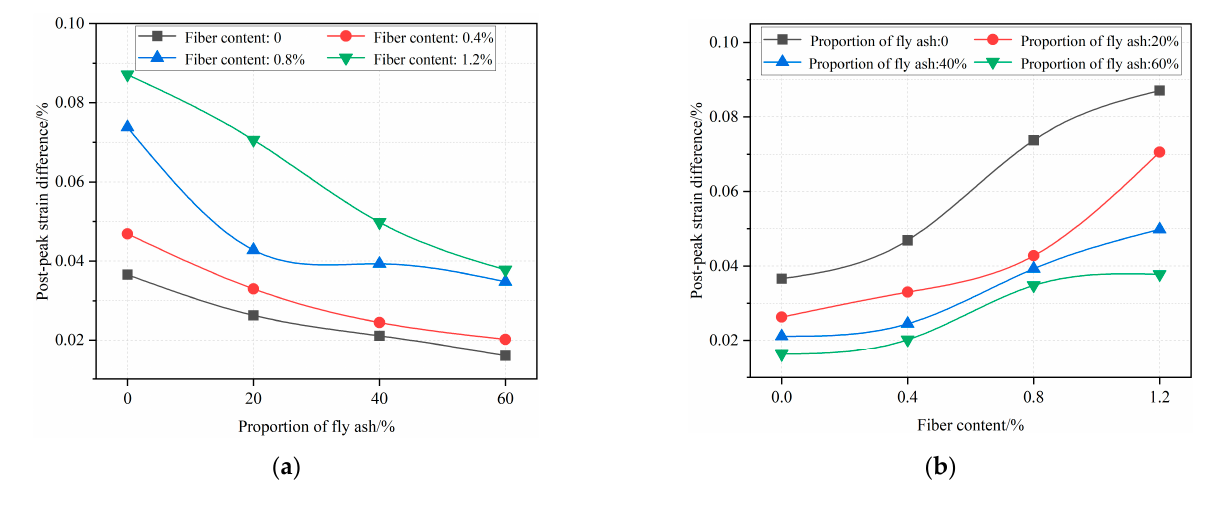
( d ) Figure 11. Brittleness and ductility failure modes of backfill: ( a ) X-shaped conjugate inclined plane shear failure; ( b ) Single slope failure; ( c ) Tensile failure; ( d ) Ductile failure. The failure modes of RBB samples after the test are shown in Figure 12. According to the failure characteristics of the backfill samples containing FA and without SF or containing SF and FA, the backfill is stripped around and the failure mode is a typical X- shaped conjugate-inclined plane shear failure. When SF is not mixed, the failure mode of backfilling body does not change with or without FA, and the failure mode is brittle failure.